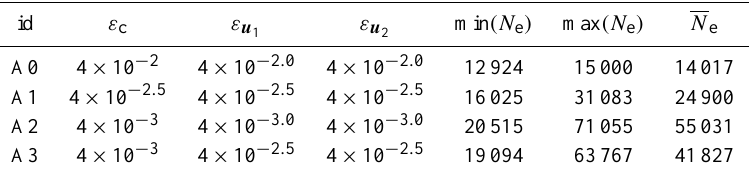
Table 1. Minimum, maximum and mean number of elements, N e , and interpolation error bounds for sediment concentration, ε c , the x com- ponent of velocity, ε u , and the y component of velocity, ε u , for selected adaptive two-dimensional simulations from the interpolation error 1 2 bound parameter sweep.